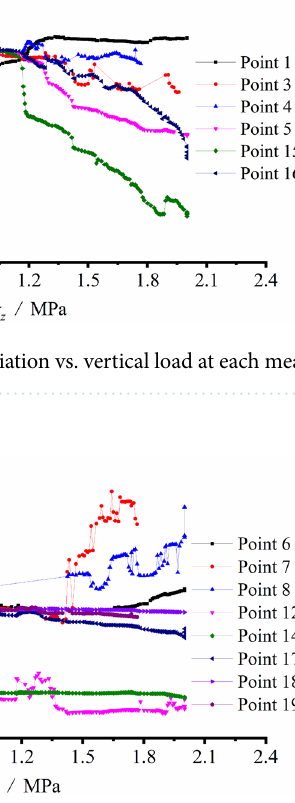
figured out and the maximum value happened at S7. As the vertical load reached 1.167 MPa, the tensile strain at each measuring spot showed upheavals followed with irregular fluctuation, which indicated that the strain gauges on the sidewall have broken. This phenomenon was consistent with the vertical tensile fracture on the vertical wall, as shown in Fig. 4b. The radial strains of S17, S18 and S19 at the arch crown were under the pressured state during loading. The compressive strain slowly grew without notable failure upheaval, suggesting the stability of